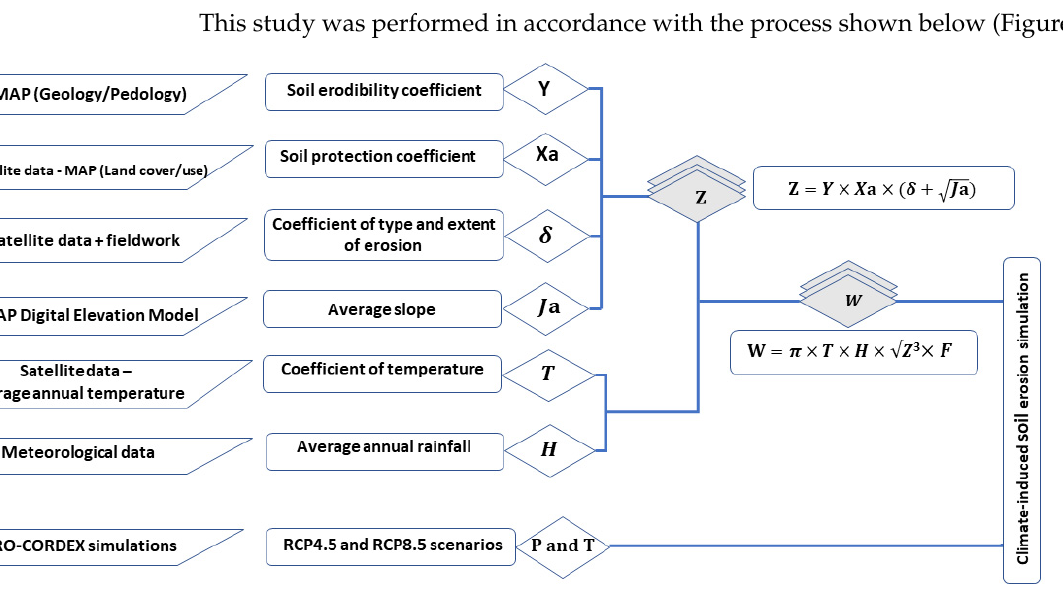
Table 4. EPM coefficient values of erosion coefficient.